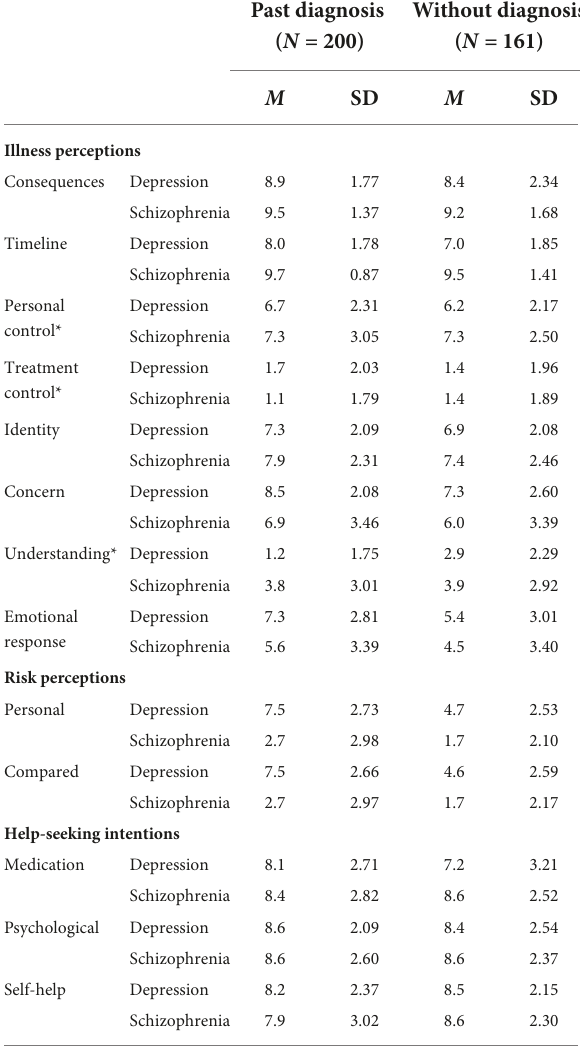
TABLE 1 Main effects of the disorder type and interaction effects–analysis of variance (ANOVA) [ n = 361, F (1, 359)].